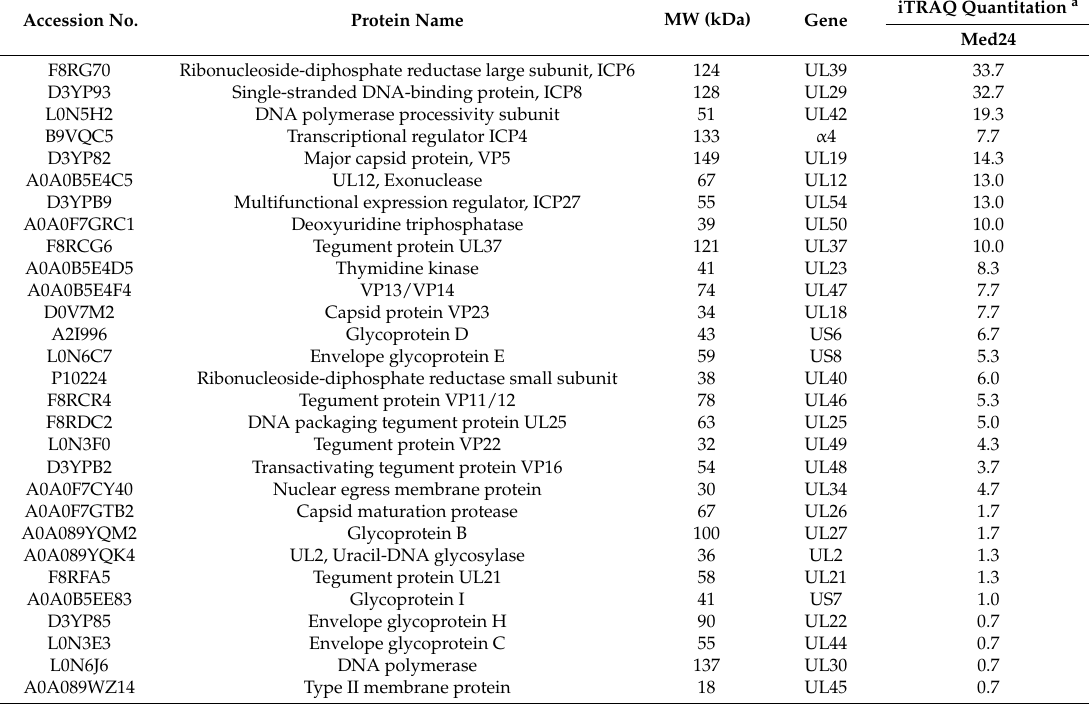
Table 4. HSV-1 proteins in secretomes. a Mean of three assessments. UL, unique sequence of the L component; US, unique sequence of the S component; ICP, infected cell protein; VP, virion polypeptide. Accession